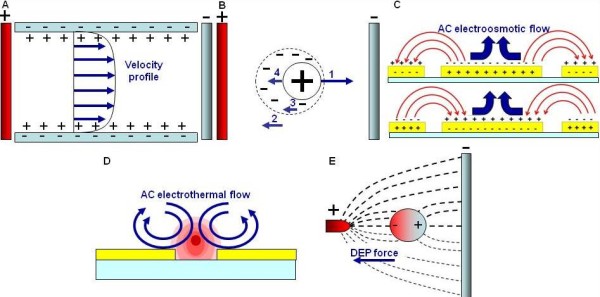
Electrokinetic platform. (A) Schematic of the formation of electrical double layer and electroosmotic flow. (B) The four forces acting on a charged particle in the electrophoresis experiment. Force 1 is the electrostatic force between the charged particle and the electric field. Force 2 is the viscous drag. Force 3 is the electrophoretic retardation. Force 4 is the electrophoretic relaxation. (C) Schematic of AC electroosmosis. (D) Schematic of AC electrothermal flow. (E) Schematic of dielectrophoresis.